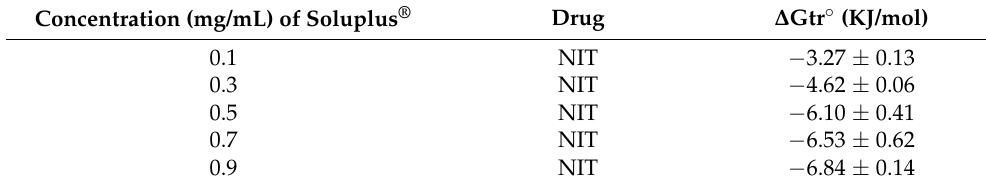
Table 3. The Gibbs free energy of transfer ( ∆ Gtr ◦ ) of NIT in PBS (pH 6.8) with pre-dissolved Soluplus ® concentrations ranging from 0.1 to 0.8 mg/mL. Standard deviations are expressed as error bars ( n = 3). Concentration (mg/mL) of Soluplus